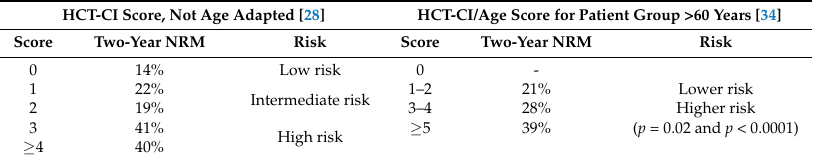
Table 1. Estimated two-year NRM in original and age-incorporating HCT-CI score. The original HCT-CI score is regardless of age, the estimated NRM by the HCT-CI/age score shown here is only based on the data of patients >60 years. HCT-CI Score, Not Age Adapted